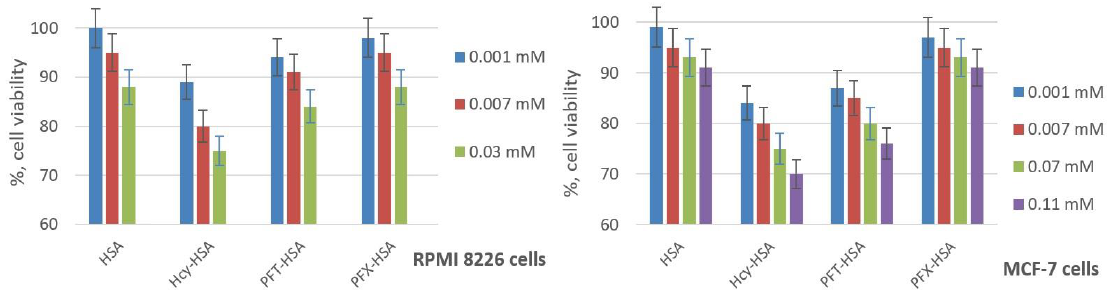
Figure 9. Effects of HSA conjugates on the viability of MCF-7 and RPMI 8226 cell lines. Cell viability was normalized using cells treated with PBS buffer as a 100% viability control. Hcy-HSA — N -homocysteinylated HSA containing 3 Hcy residues.